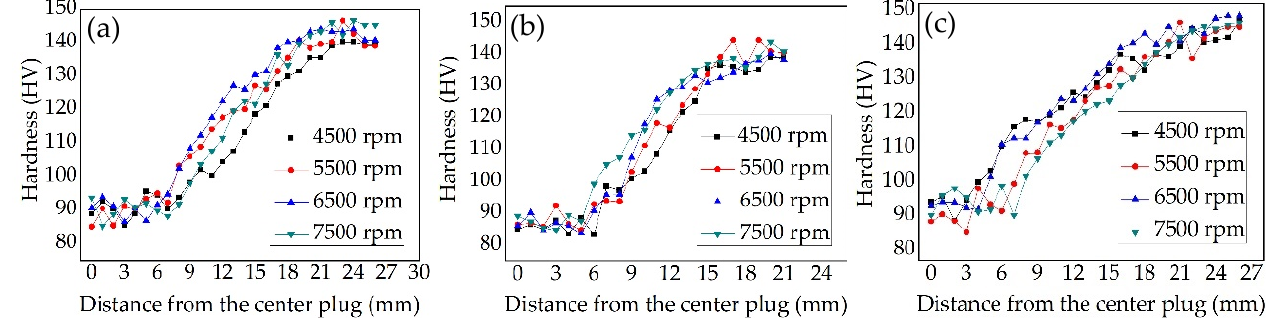
Figure 7. Hardness distribution of FPW joints: ( a ) top, ( b ) middle and ( c ) bottom.